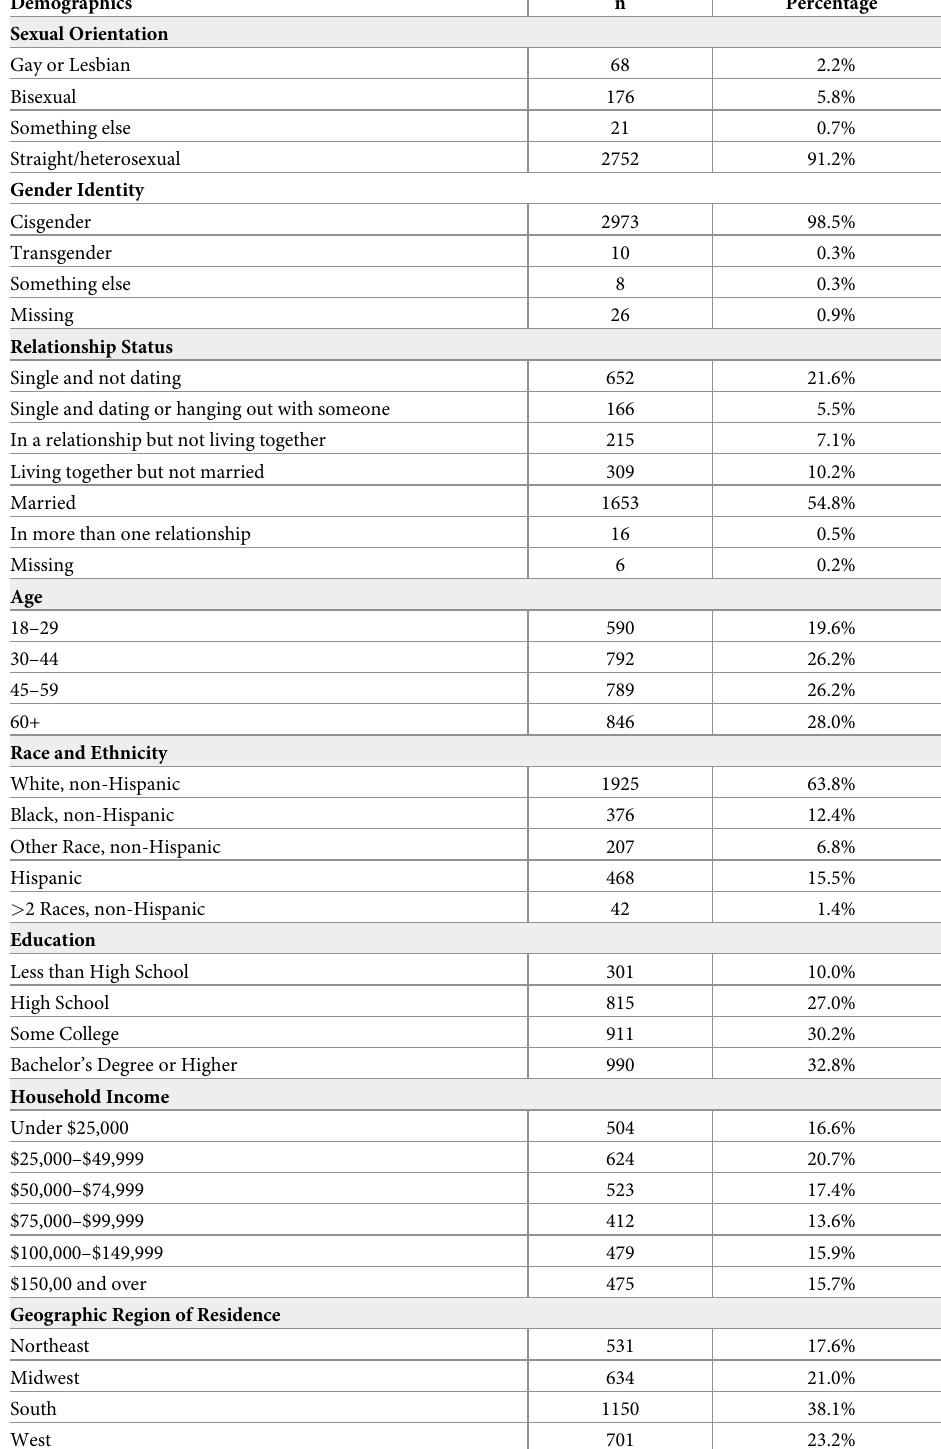
Table 1. Demographics of national probability sample of 3017 U.S. women